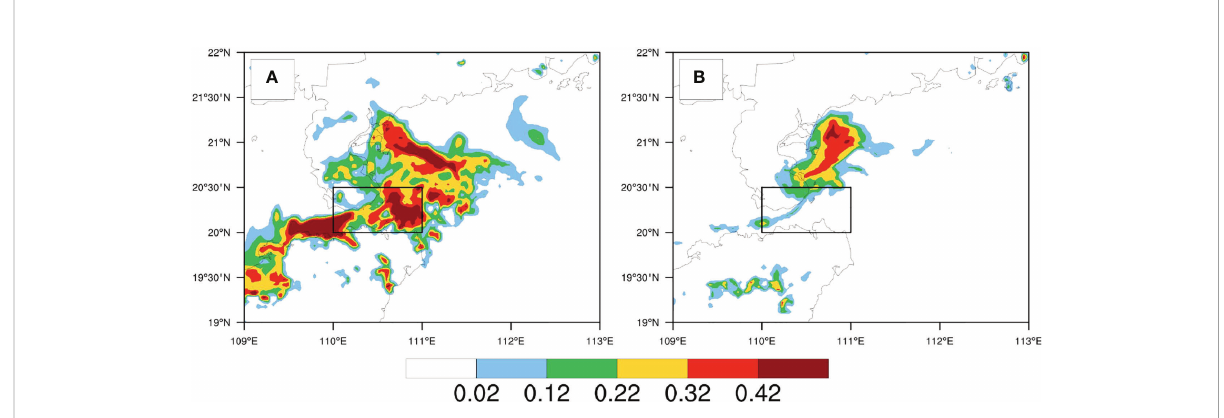
FIGURE 7 Spatial distribution of LWC (g·m -3 ) at the lowest model level at 0700BJT on March 11th, 2017 as forecasted by (A) the coupled model and (B) the uncoupled model.